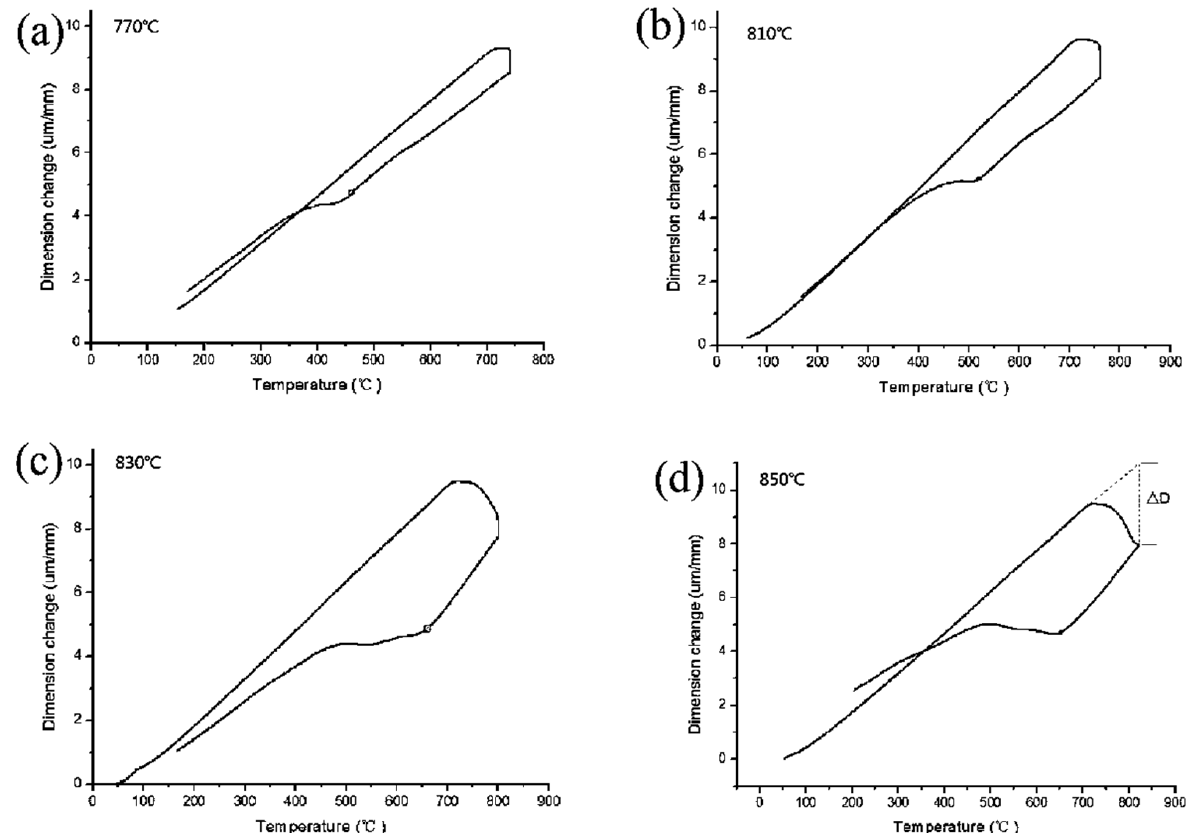
Figure 7. Thermal expansion curves of SXQ500/550DZ35 at different temperatures. ( a ) 770 °C, ( b ) 810 °C, ( c ) 830 °C and ( d ) 850 °C.